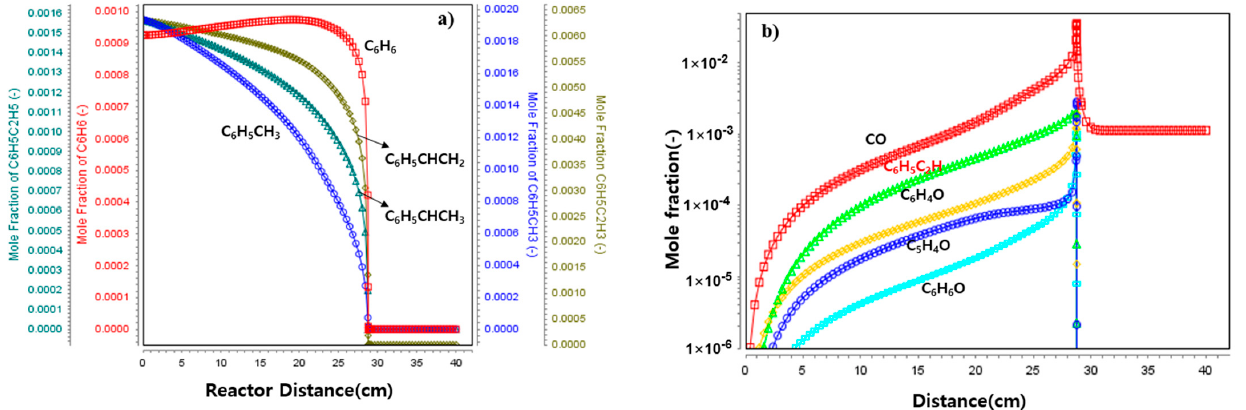
Figure 11. Concentrations of fed UHCs ( a ) and those of newly formed UHCs and CO ( b ) at a ϕ value of 0.5 and temperature of 750 °C as a function of the reactor distance.